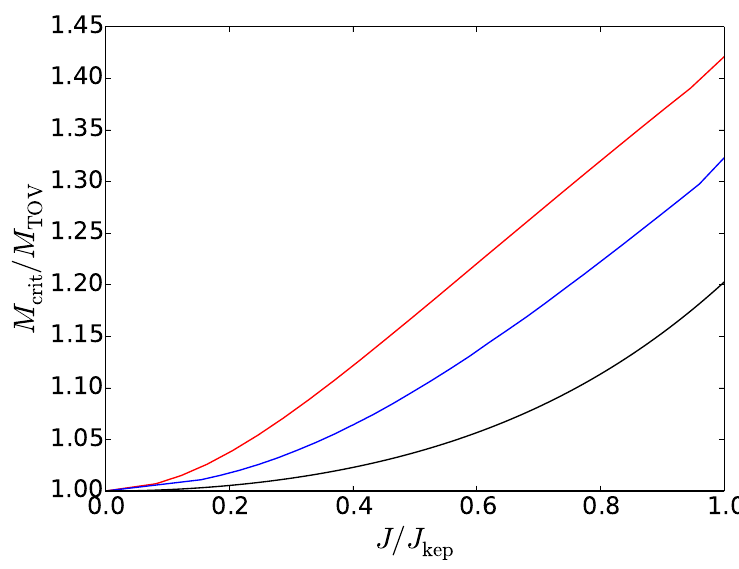
Figure 1. Relationship between normalized critical mass and the normalized angular momentum for rotating eutron stars (NSs) and quark stars (QSs). Bottom black line is the quasi-universal relationship found by [15]. Blue curve in the middle is the relationship for rotating QSs with strangeon star model and the top red line represents the relationship for the MIT bag model. The universal relationship cannot be extended for QSs